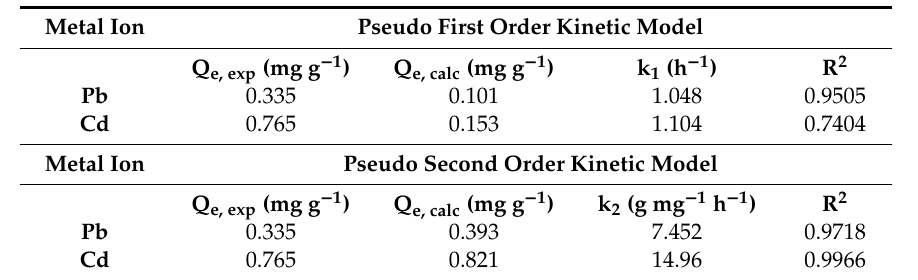
Table 3. Pseudo first-order and pseudo second-order kinetic models for the adsorption of Pb and Cd ions on powdered biomass.